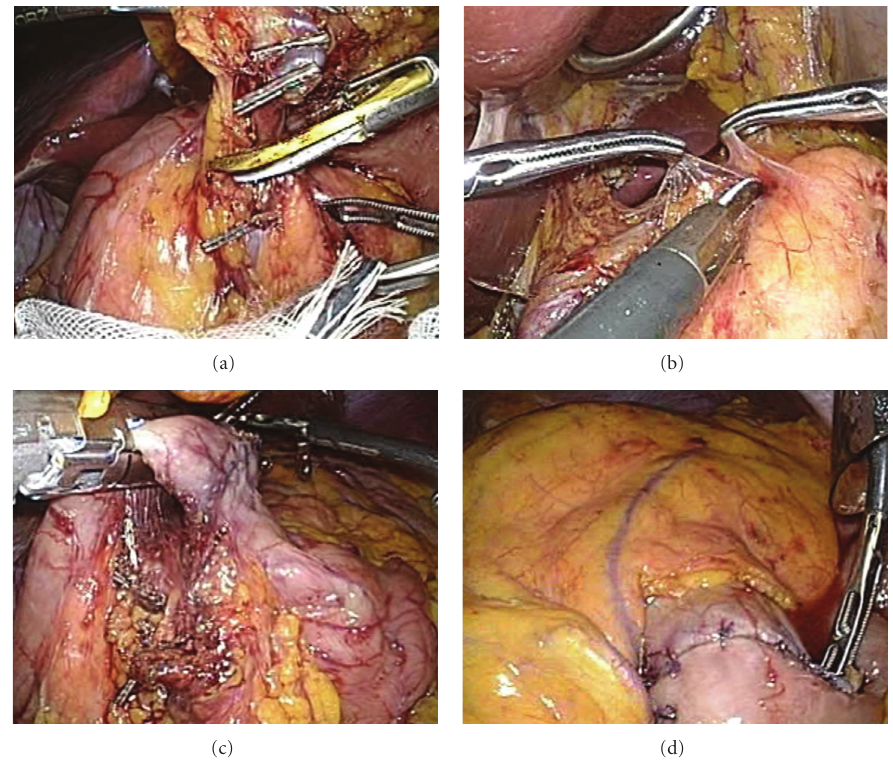
Figure 2: Intraabdominal findings from the laparoscopy-assisted distal gastrectomy with lymphadenectomy. (a) Dissection of the infrapyloric lymph nodes (station 6) from the pancreatic head: the right gastroepiploic vessels were exposed and divided. (b) Dissection of lymph node stations 7, 8a, 9, and 11p: suprapancreatic lymph nodes and lymph nodes around the celiac axis were dissected along the common hepatic artery and the splenic artery. (c) Transection of the duodenum: the duodenum was cut 1 cm distal to the pylorus using an endoscopic stapling device (Endo GIA, Duet TRS, Covidien, Tokyo, Japan). (d) Anastomosis: a Roux-en Y gastrojejunostomy was made. The jejunal limb was pulled up through the retrocolic route.